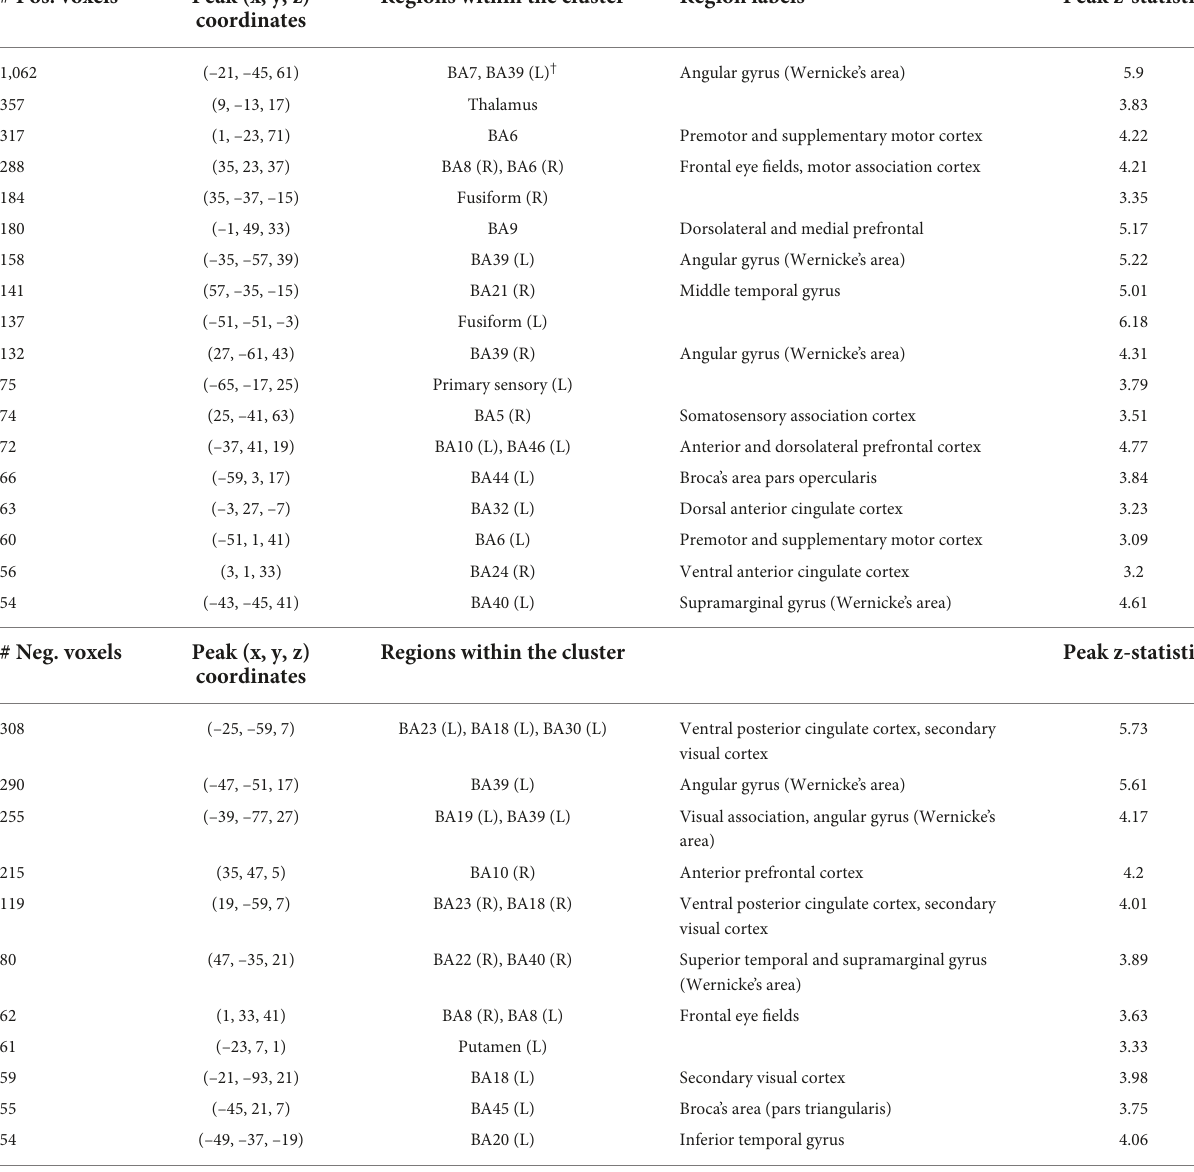
TABLE 1 Characterization of component 8 voxel-based morphometry gray matter